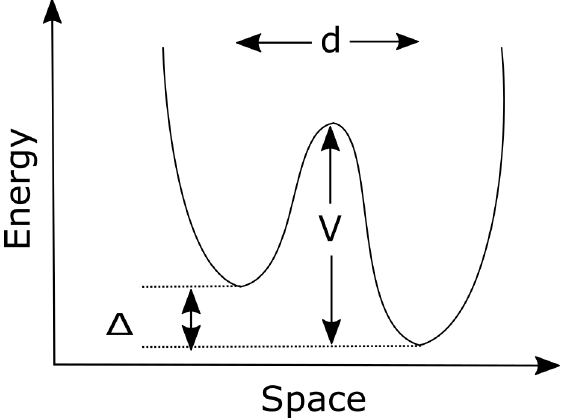
Figure 12. The potential landscape for a two-level fluctuator. Each amorphous insulator has many such potential landscapes described by distributions in V , d , and ∆